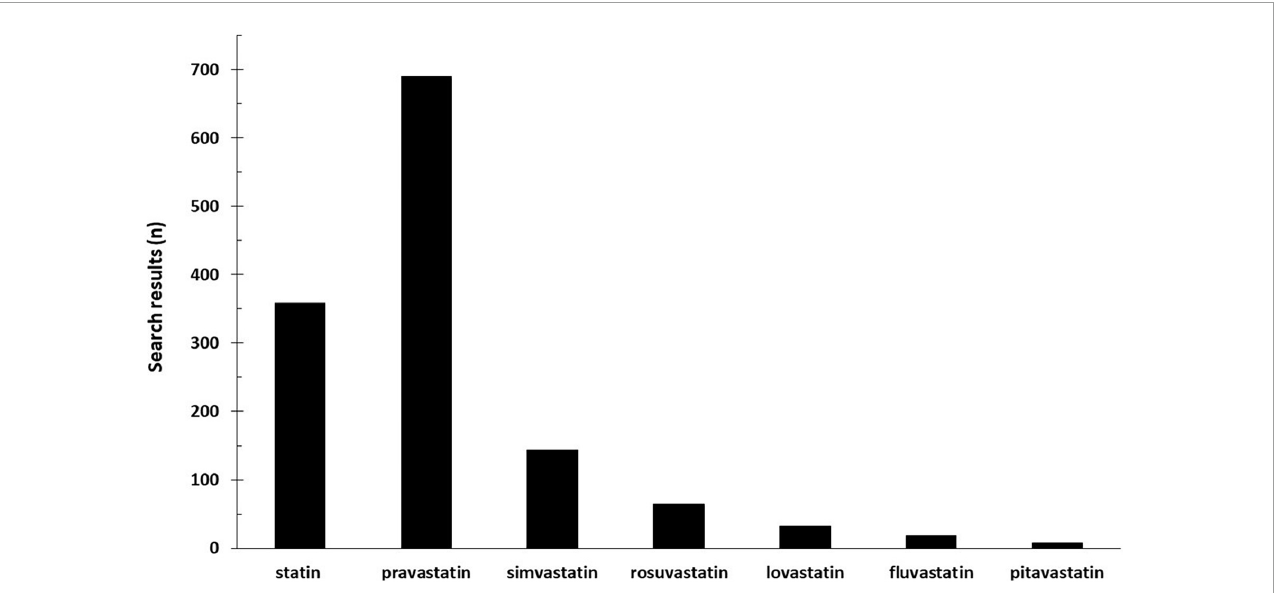
FIGURE1 Number of hits for search terms “statin AND preeclampsia” databases: PubMed, Cochrane, Embase, Web of Science, Scopus, and www.clinicaltrials.gov.